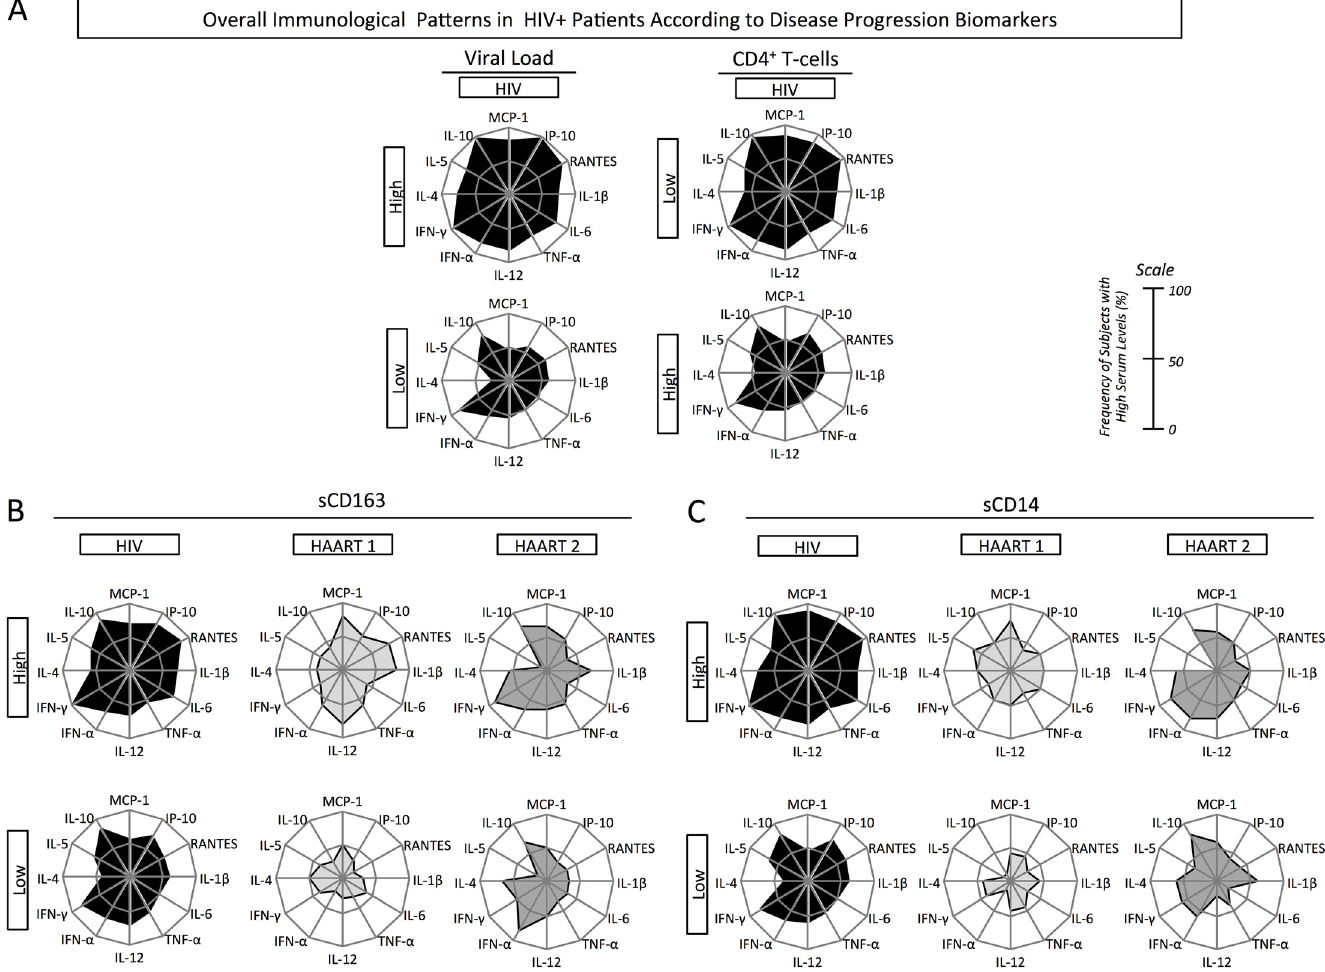
Fig 3. Immunological biosignature of untreated and treated HIV+ patients under two antiretroviral regimens, according to disease progression. Viral load, CD4+ T cell counts, sCD163, and sCD14 levels were used as progression biomarkers to classify HIV+ patients in patients presenting rapid (upper charts) or slow (lower charts) disease progression. Plasma concentration of MCP-1, RANTES, IP-10, IL-1 β , IL-6, TNF- α , IL-12, IFN- α , IFN- γ , IL-4, IL-5, and IL-10 was used to characterize the immunological biosignature of HIV+ patients. Radar charts summarize the percentage of high producers of each group studied. A) Biosignature of untreated HIV patients according to viral load and CD4 count categorization. B) Biosignature of untreated HIV, HAART 1, and HAART 2 patients according to the levels of plasma sCD163. C) Biosignature of untreated HIV, HAART 1, and HAART 2 patients according to the levels of plasma sCD14. Significant changes in biomarker production were considered when the frequency of high producers was greater than 50% (on a scale of 0 – 100%).